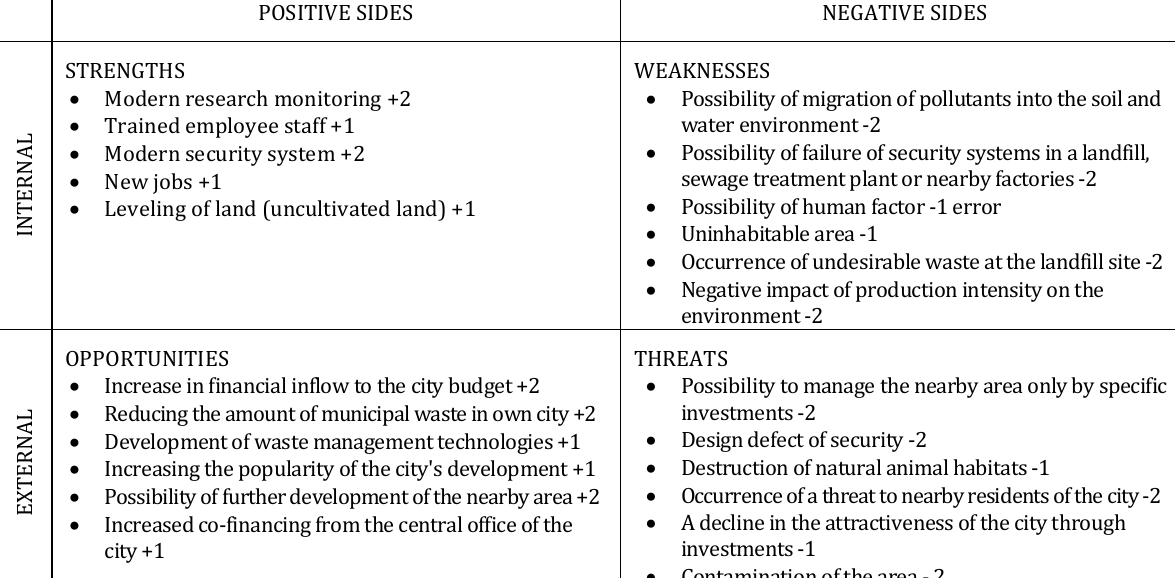
Table 2. SWOT analysis results for groundwater in the region of the municipal landfill